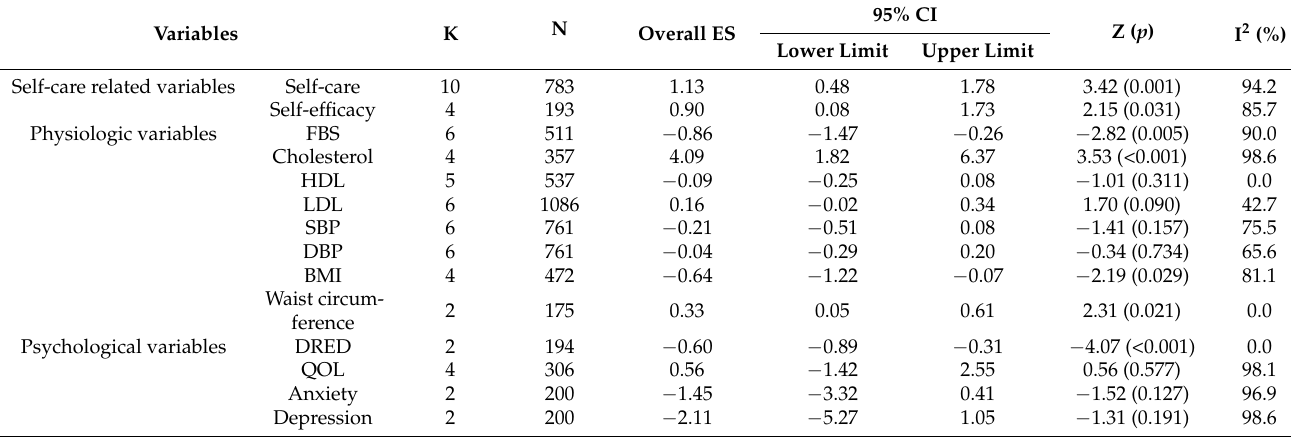
Table 6. The effect of self-management nursing intervention on secondary